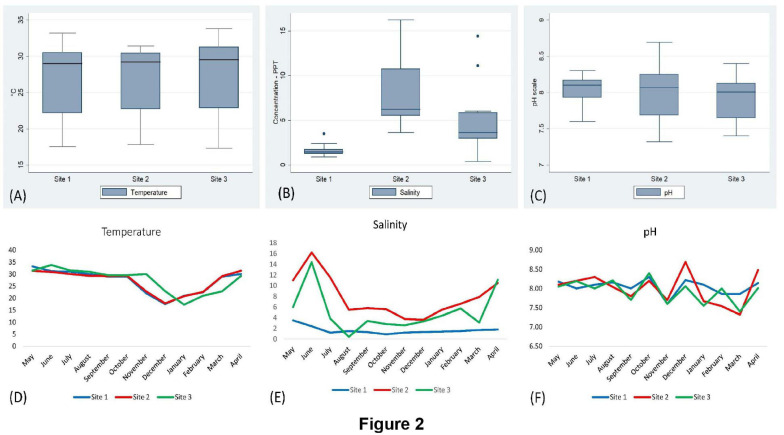
Analysis of physicochemical parameters (temperature, salinity, and pH). Box and whisker plot analysis of temperature (A), salinity (B), and pH (C) in sites (1), (2), and (3). Seasonal variation of temperature (D), salinity (E), and pH (F) in different sites.